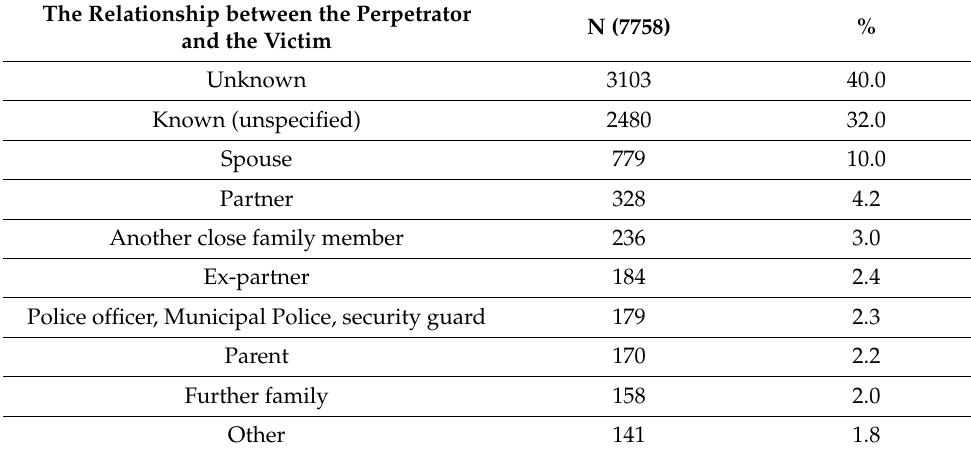
Table 10. The relationship between the perpetrator and the